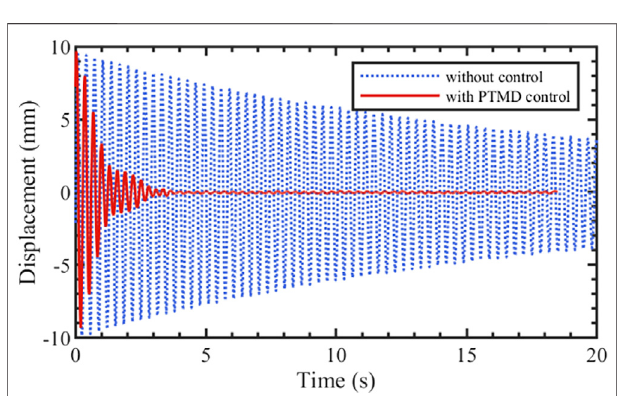
FIGURE 6 | Displacement response of portal frame in time domain.